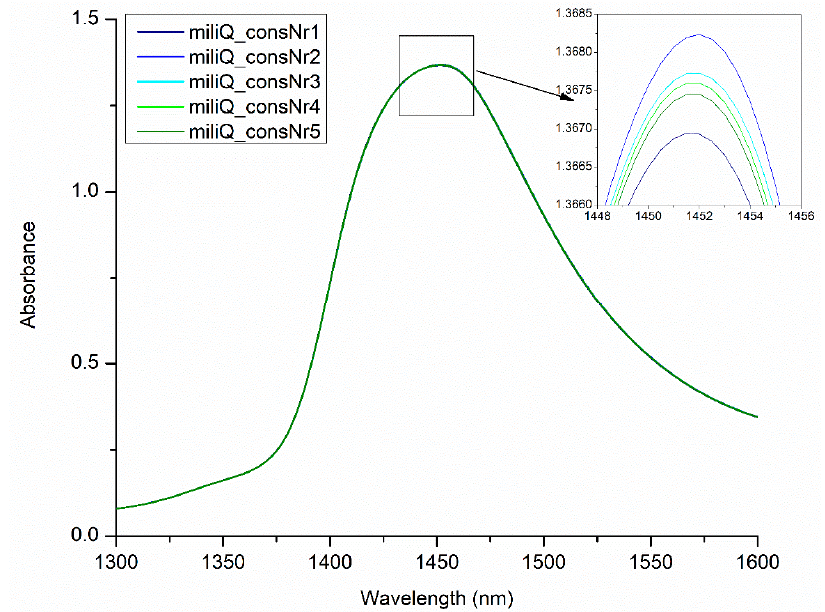
Figure 4. Spectra of pure water subjected to consecutive illuminations (the same spectra presented in Figure 3) in the area of the first overtone of water.